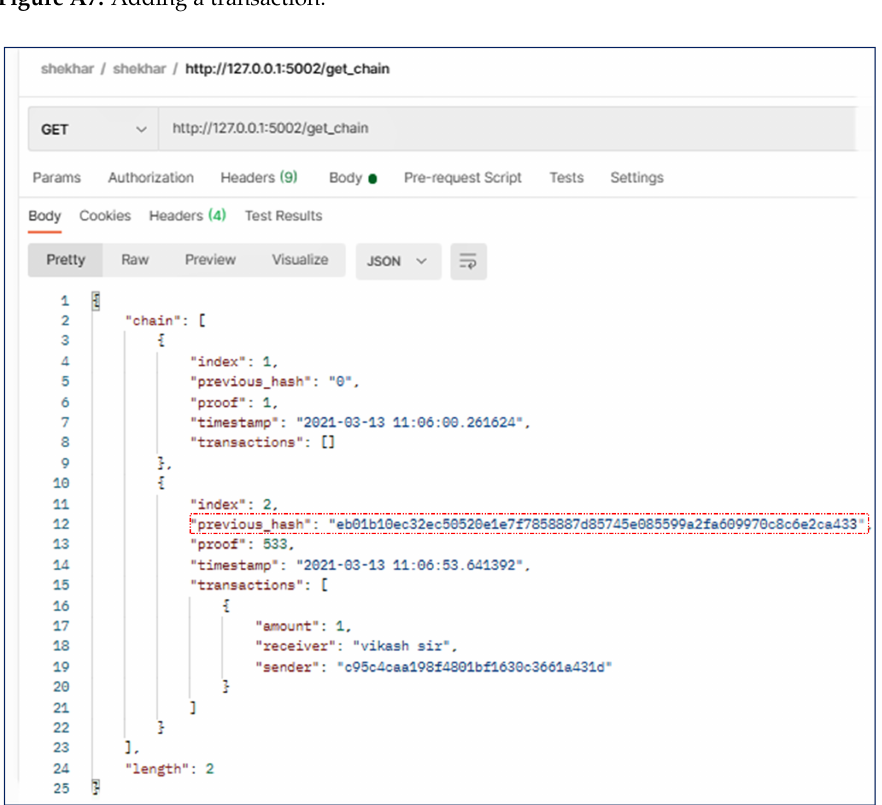
Figure A8. Transaction will not be added in a